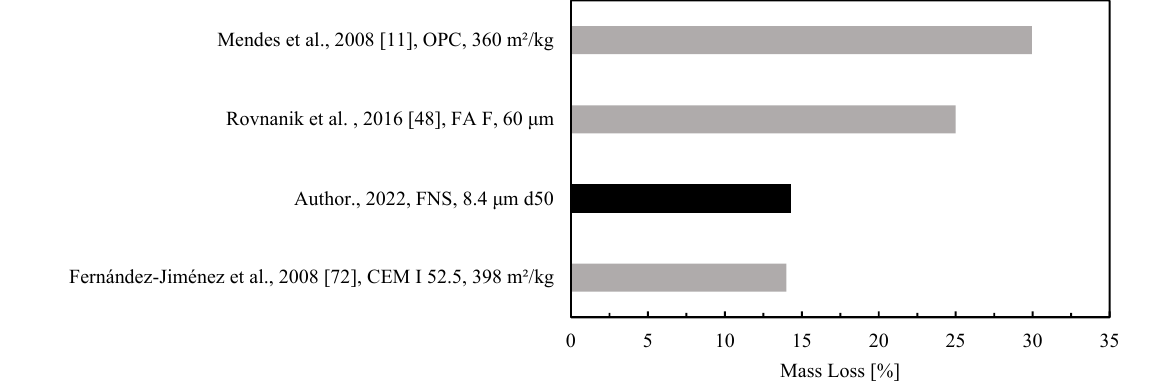
Figure 4. Mass loss of low-calcium alkali-activated and cement-based pastes after exposure to a thermal load between 800 and 1000 °C.